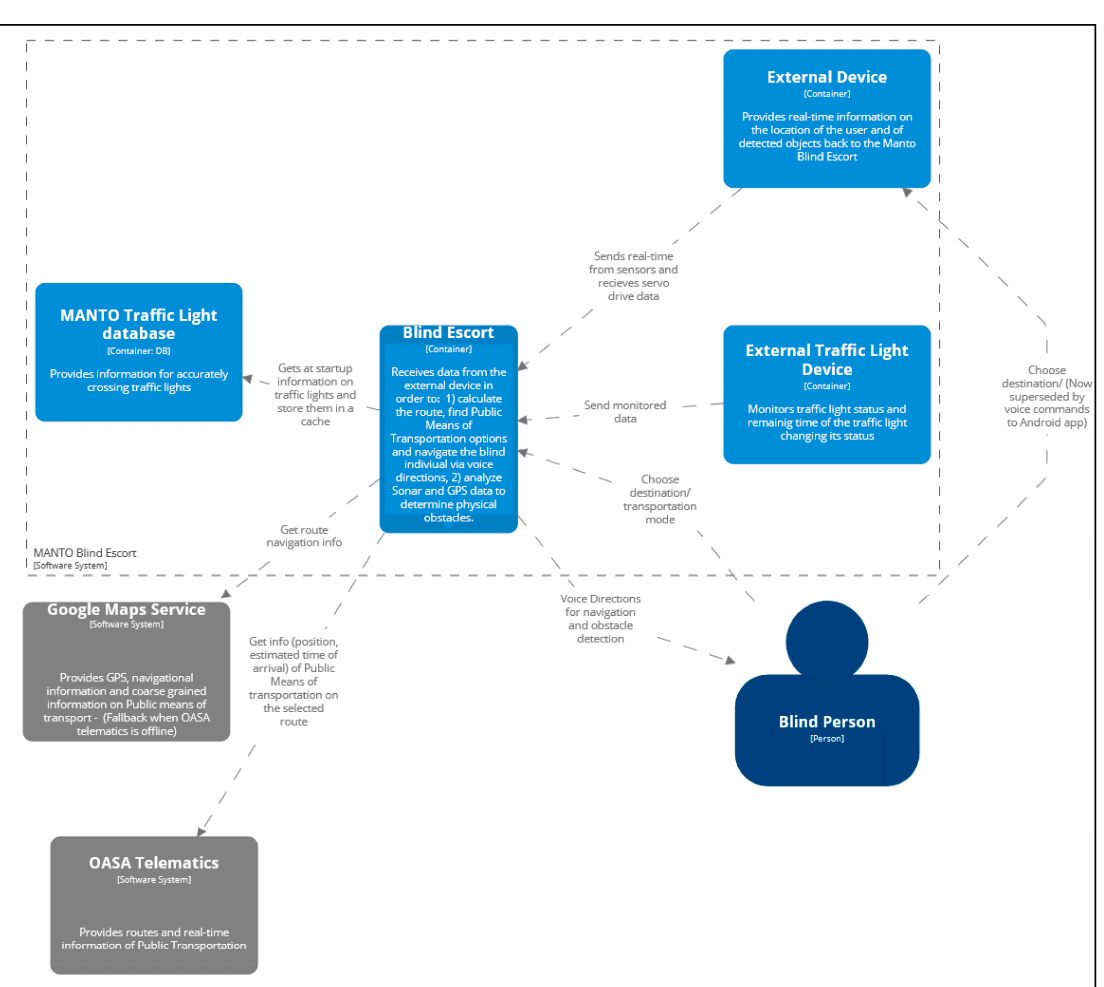
Figure 1. The application’s architectural diagram.